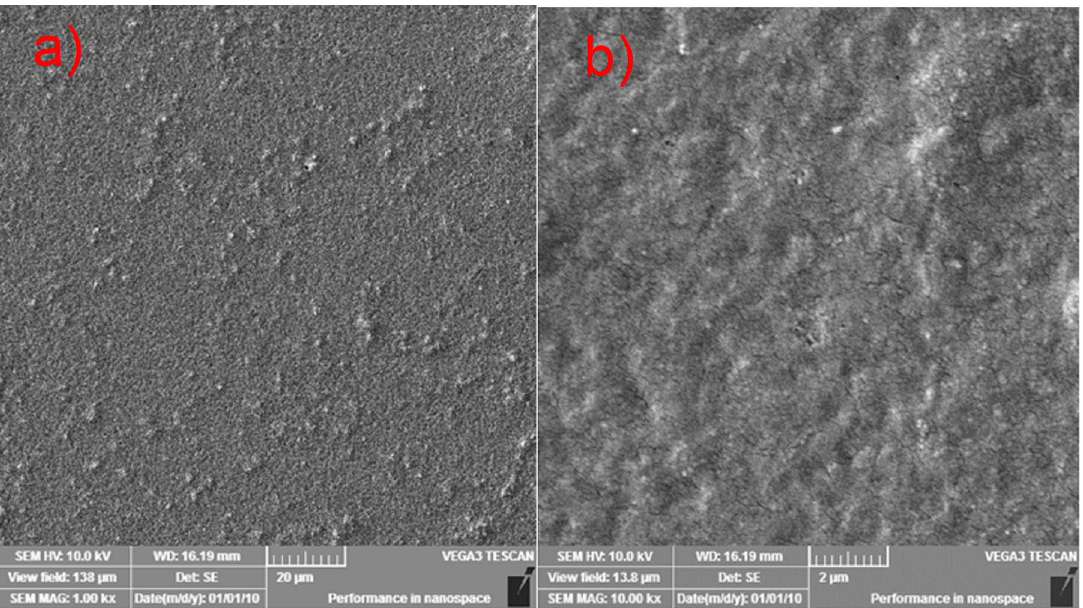
Figure 6. SEM images for GLM film cast on glass sheet at two magnifications a) 1,000X and b)